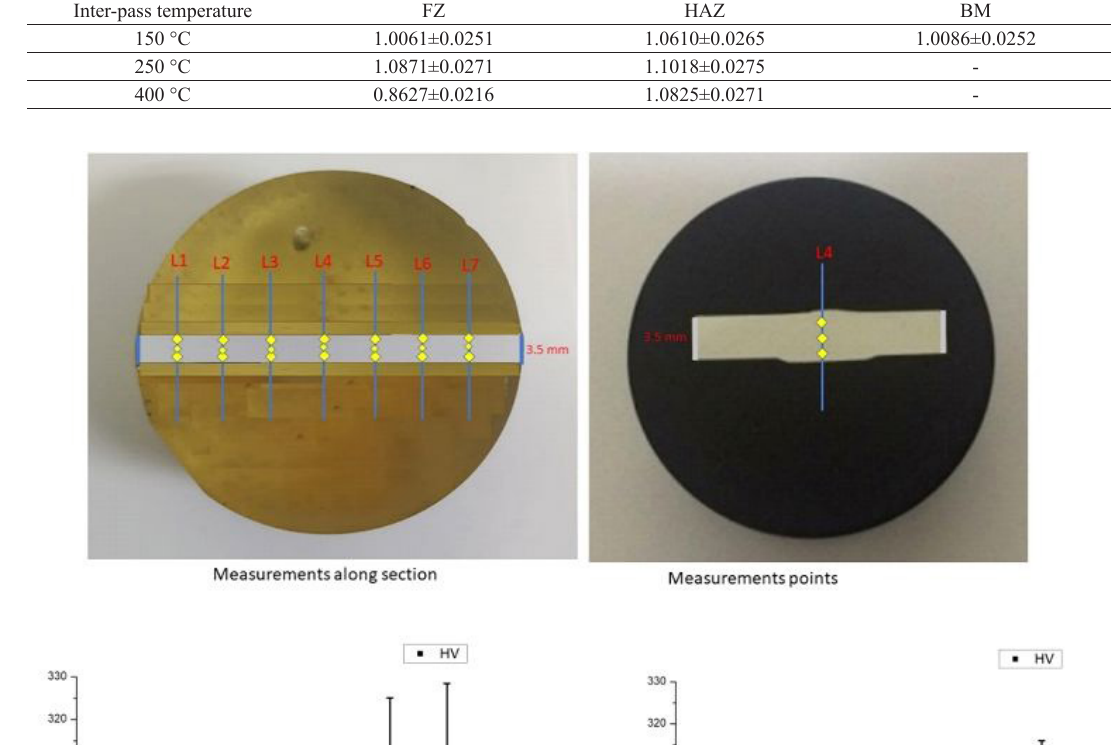
(mV), for each inter-pass temperatur for the various welding zones. Table 6. Pitting potential, E pitt Inter-pass temperature